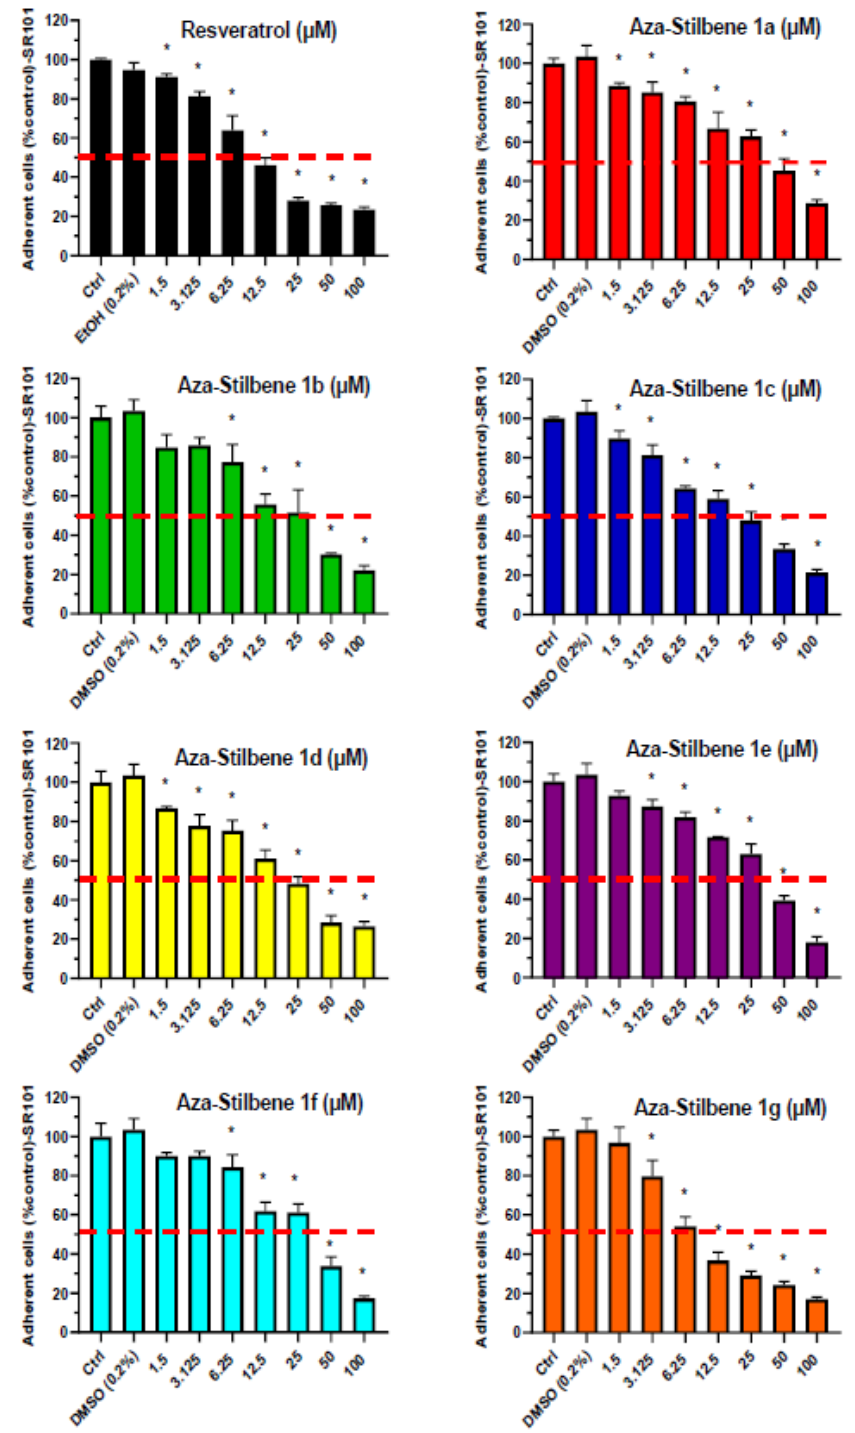
Figure 3. Evaluation with the sulforhodamine 101 (SR101) assay of the effects of resveratrol and aza-stilbenes 1a to 1g on cell density. N2a cells were incubated for 48 h with or without resveratrol or aza-stilbenes 1a to 1g in a range of concentrations from 1.5 to 100 µ M. Cell density evaluated with SR101 reflects the quantity of adherent cells. The dotted red line makes it possible to evaluate the value of the concentration or the range of concentrations reducing the number of adherent cells by 50% (IC50). Data are the mean ± SD of two independent experiments performed in triplicate. Significance of the differences between control (untreated cells), Resveratrol ( trans ‐ resveratrol) or aza ‐ stilbenes 1a to 1g –treated cells; Student’s t test: * p < 0.05 or less.